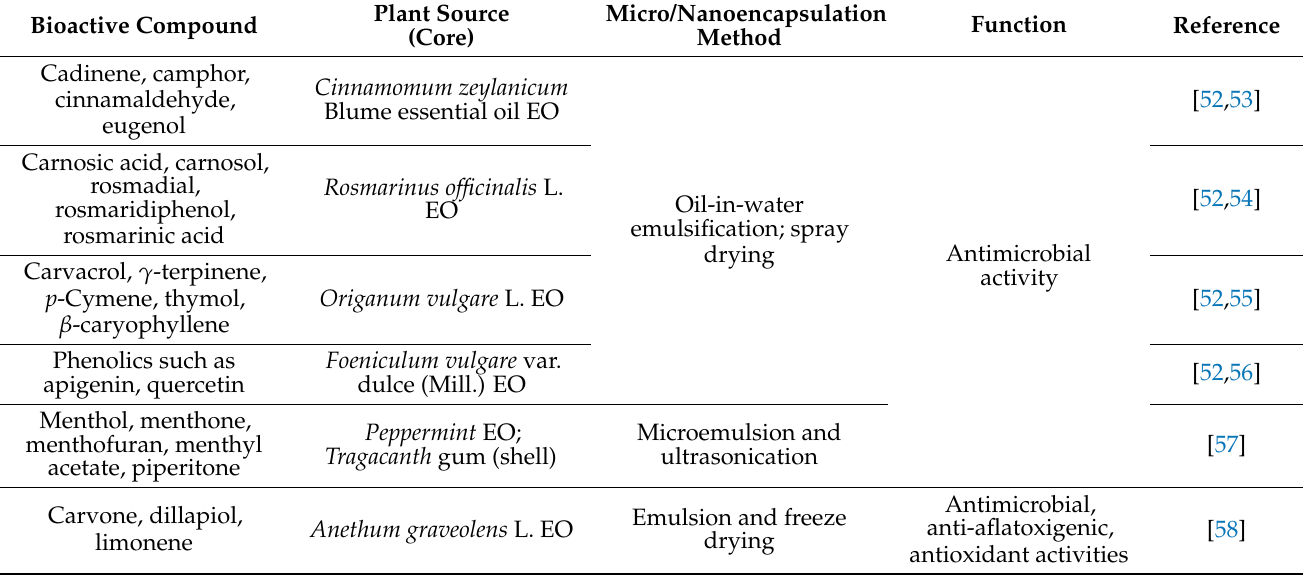
Table 2. Micro- and nanoencapsulated bioactive compounds, plant sources, and functionalities for food